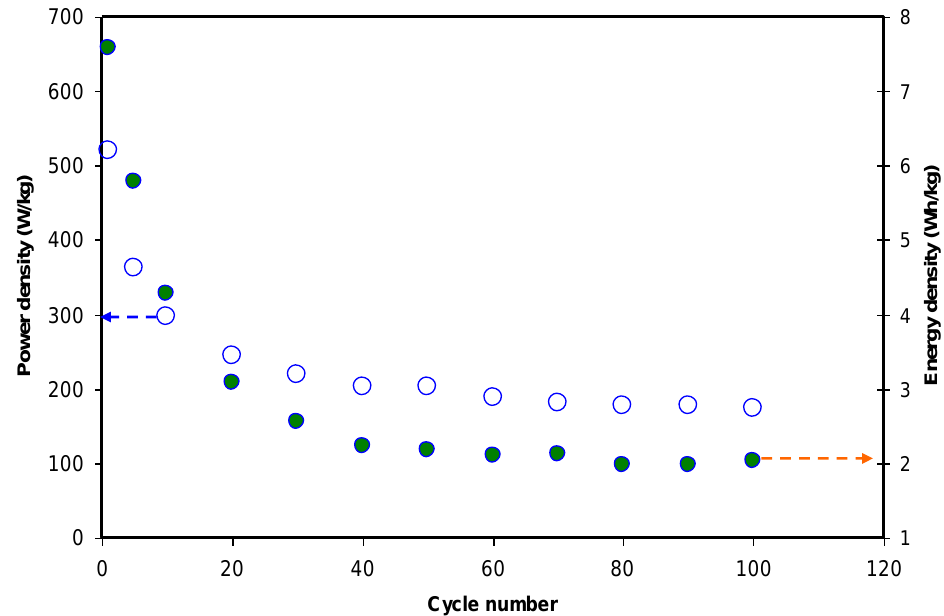
Figure 13. Energy density (E d ) and Power density (P d ) of the assembled EDLC up to 100th cycle. Power density ( P ) is simply defined as the amount of energy that delivered per unit